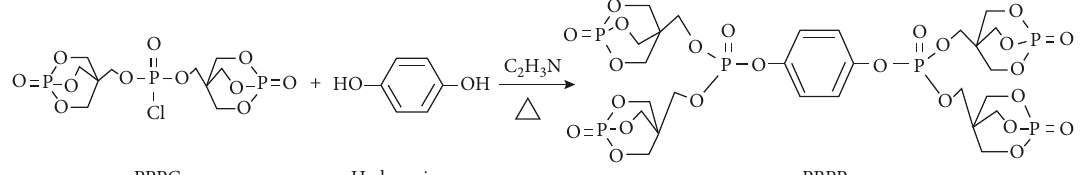
Scheme 2: Synthesis of